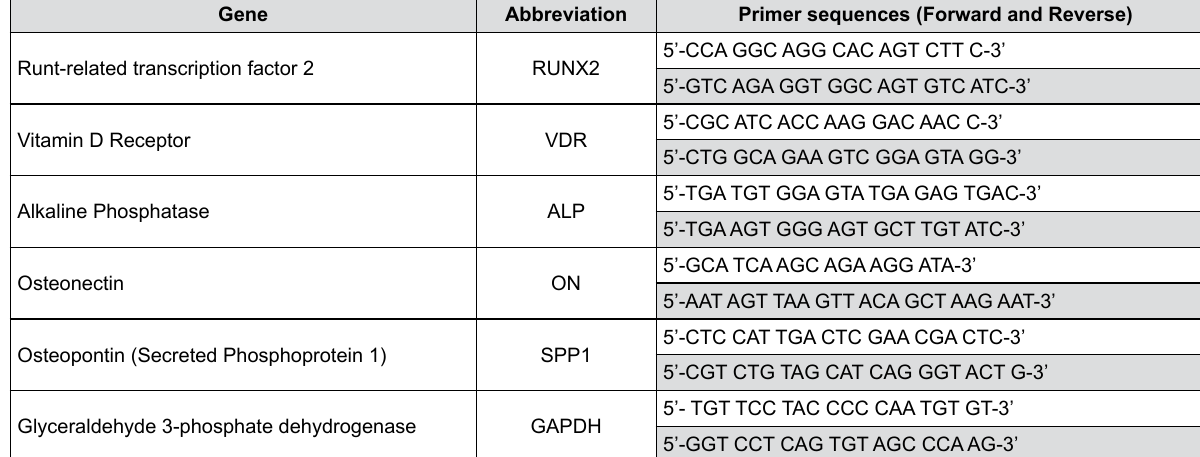
Figure 1- Sequences of primers used for RT-PCR